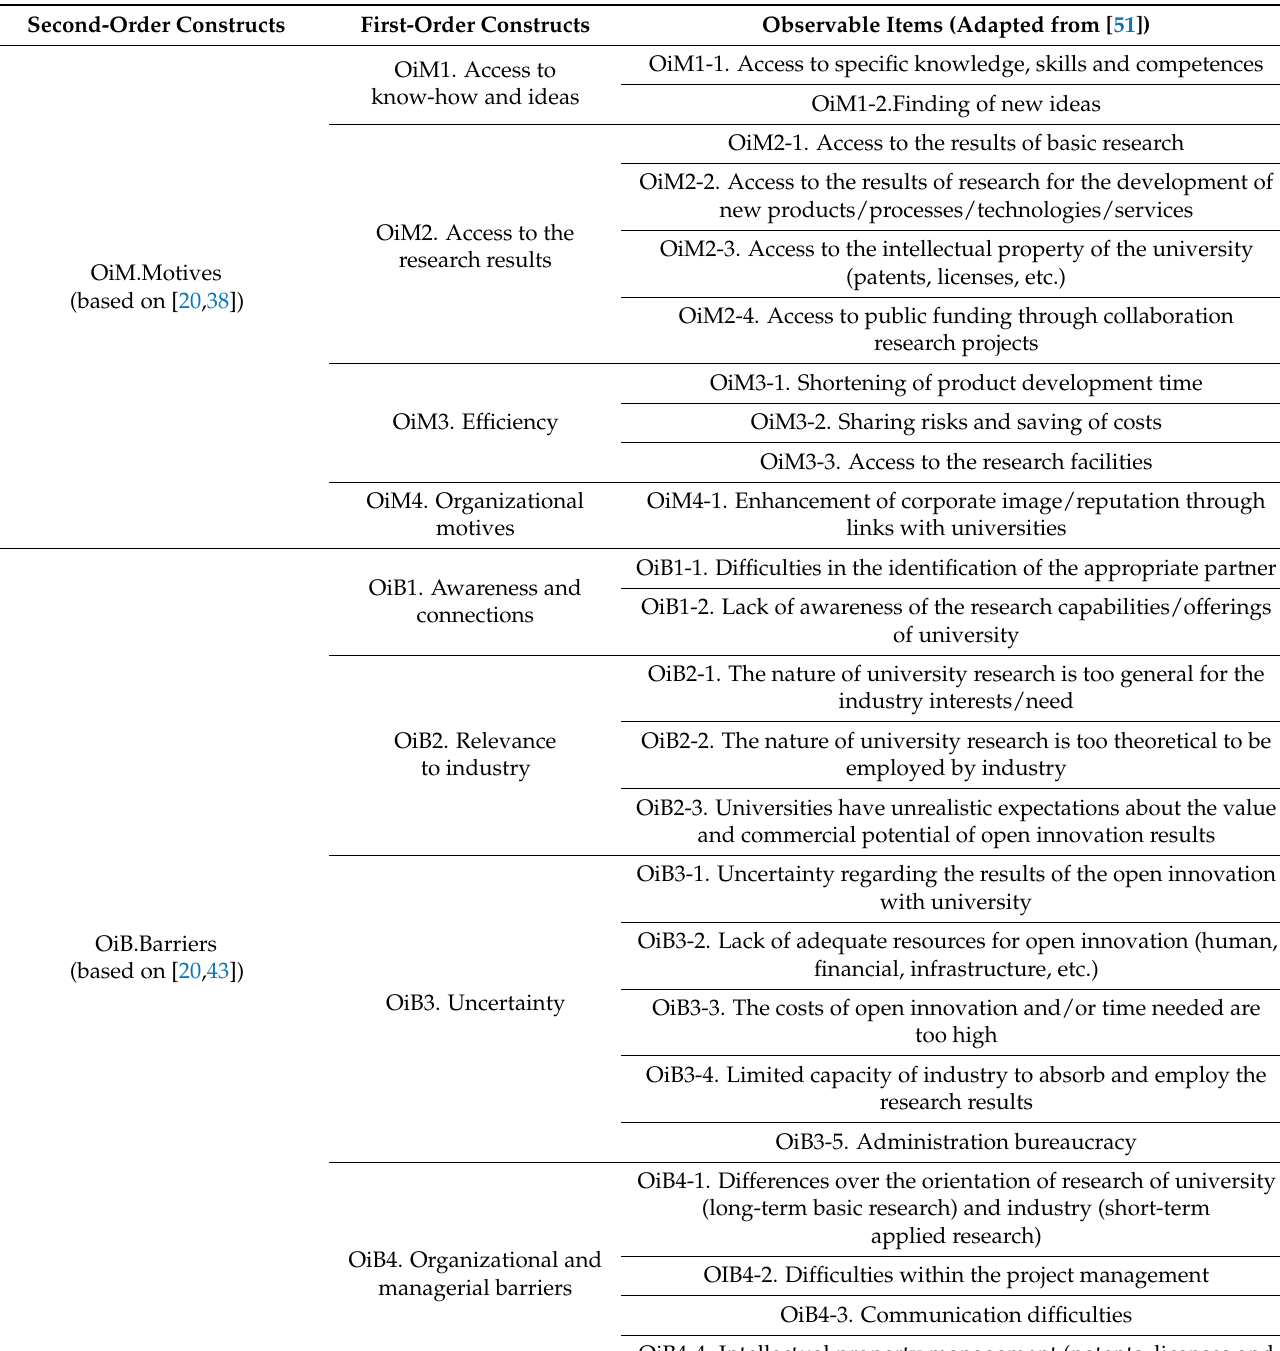
Table 1. Hierarchical constructs of the